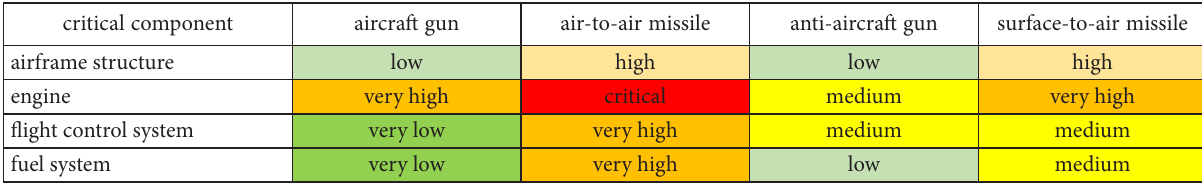
Table 5. Estimation of susceptibility to destruction in combat for F-16